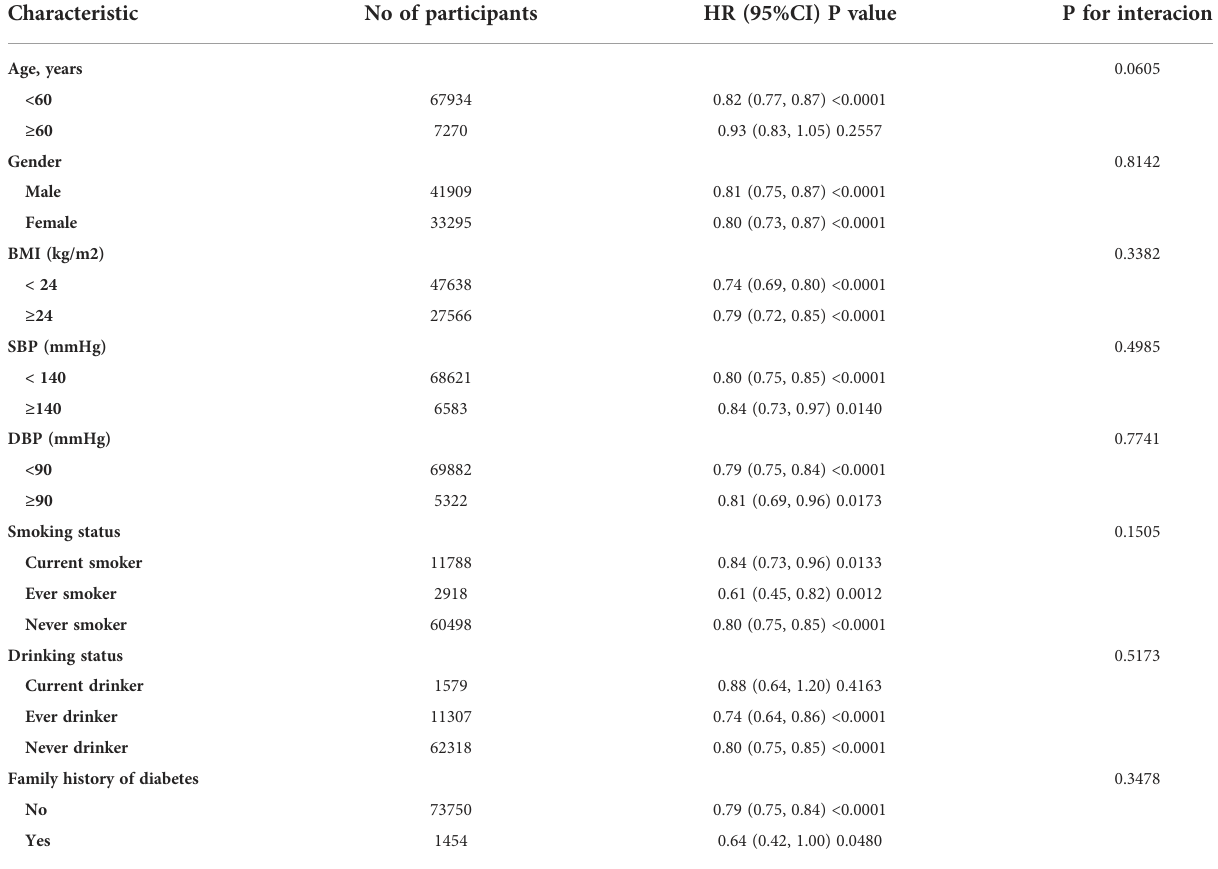
TABLE 7 Effect size of AST/ALT ratio on prediabetes in prespeci fi ed and exploratory subgroups.